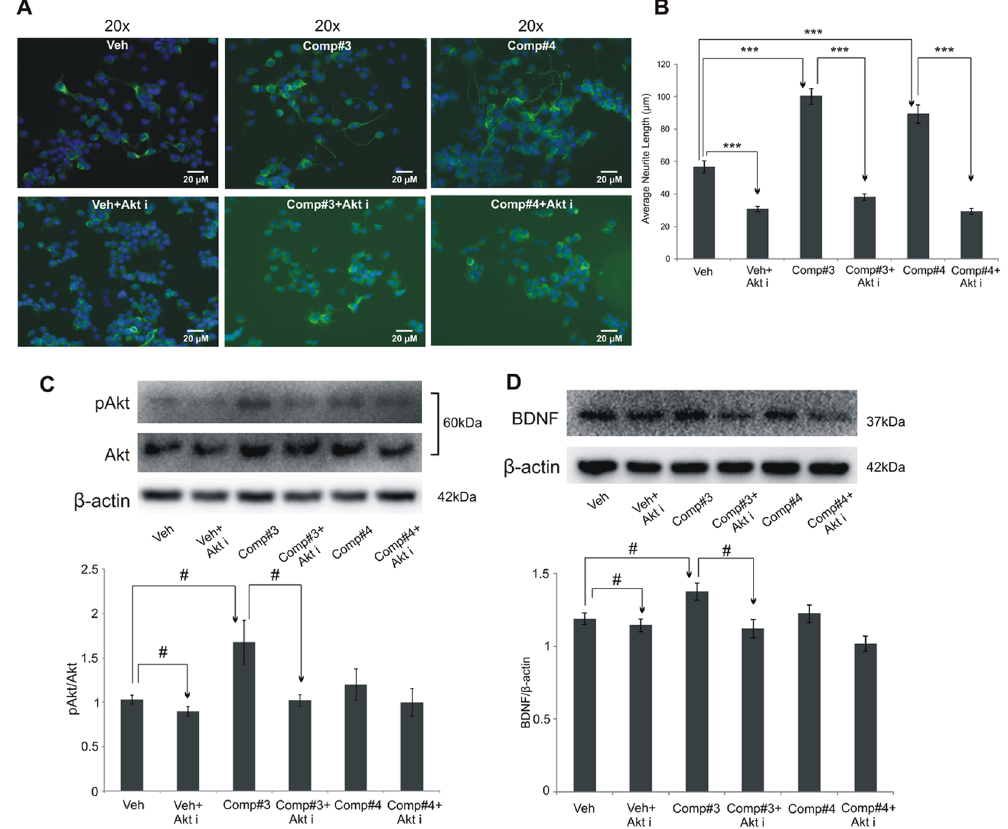
Figure 6. Mechanistic studies to uncover the mechanism of compounds’ neurotrophic action in vitro using AKT inhibitor (Akt i). Morphometric analysis of neurite outgrowth in differentiated Neuro2Acells treated with #3(0.01 μ M) and #4(0.01 μ M), pretreated (with or without AKT i, LY294002) (20 μ M). Results were analysed by one-way ANOVA (with posthoc Tukey test) ( A,B ). Protein expression of pAKT-AKT ( C ) and BDNF ( D ) in Neuro2A cells treated with #3(0.01 μ M) and #4(0.01 μ M). Values are represented as mean ± SE with n = 3; Results analysed by either one-way ANOVA followed by post hoc Tukey test ( A,B and E,F ) represented as ( * ) or two-tailed unpaired student’s t-test for pairwise comparison between various groups represented as ( # ) where # p < 0.05 and *** p <